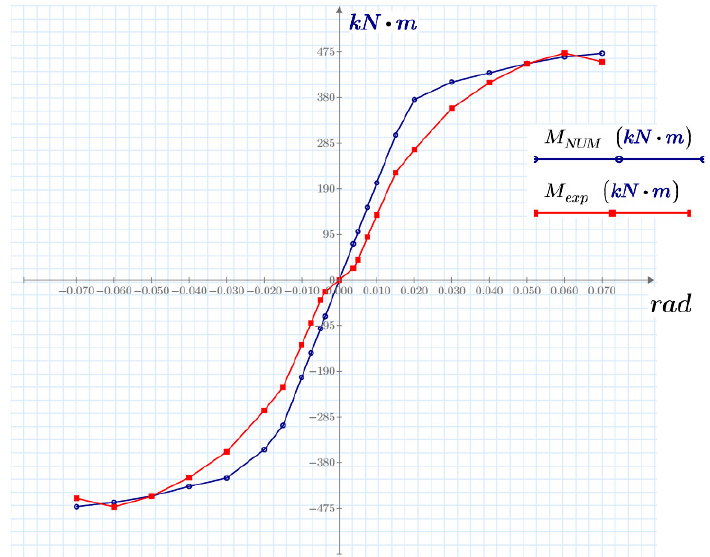
Figure 11. Numerical envelope of the moment–angle curve.